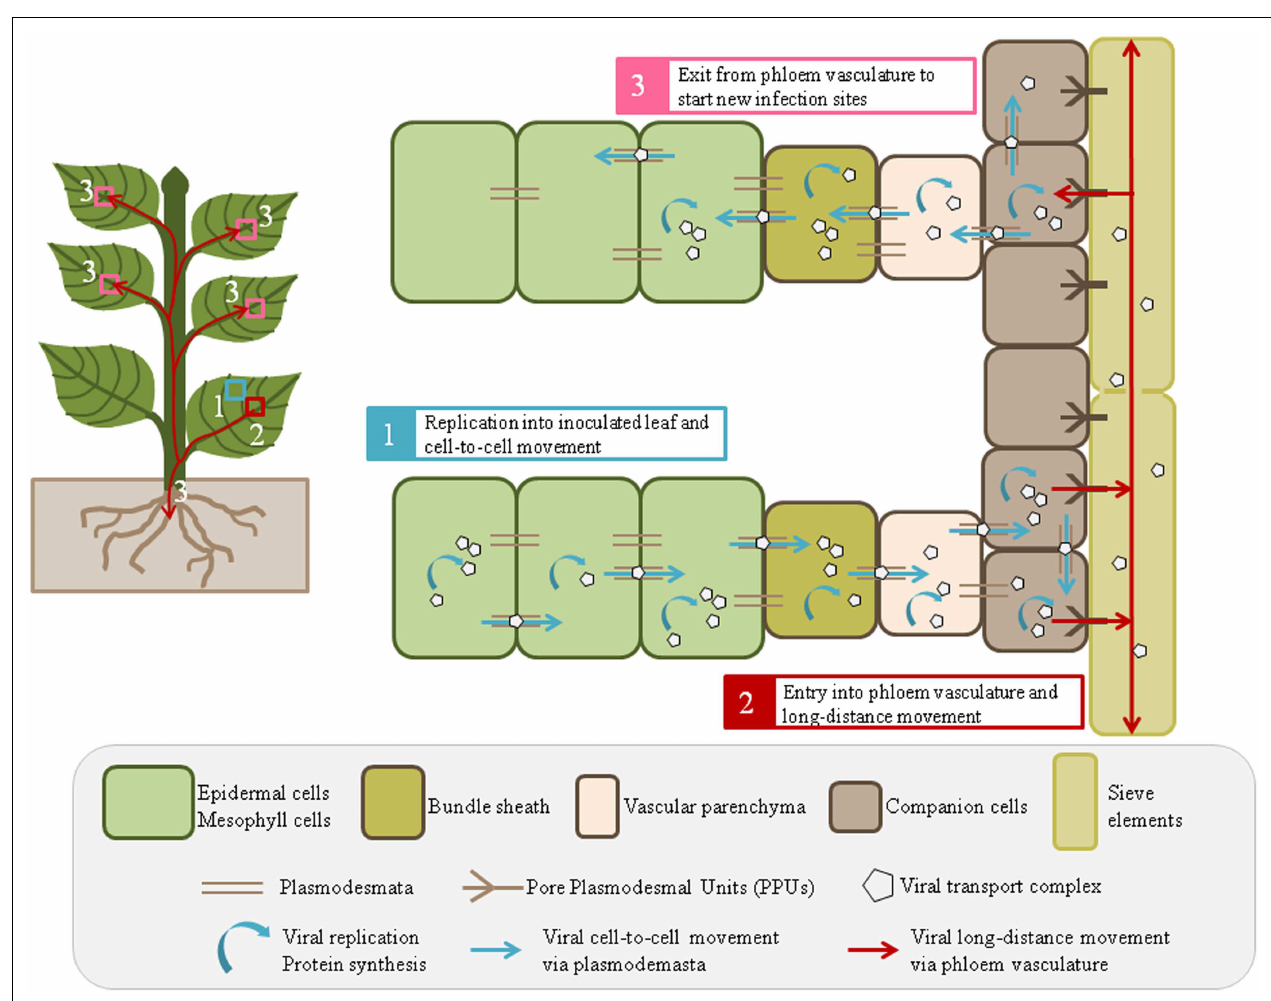
and between nucleate phloem cells, i.e., bundle sheath, vascular parenchyma and companion cells (2).Then, the transport complexes (in the form of virions or RNPs) are loaded into sieve elements for long-distance movement (2), before being finally released into systemic tissues to start a new infection site (3).The whole process requires an effective crossing of successive boundaries between different cell types and leads to systemic infection of the